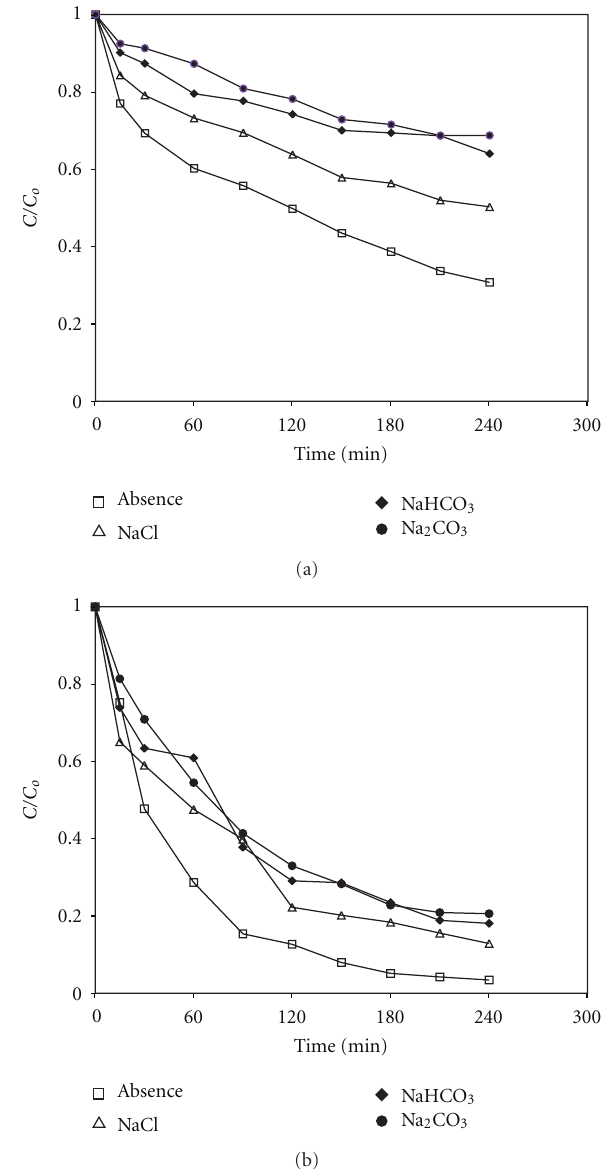
Figure 13: E ff ect of presence of coexisting ions on photocatalytic degradation (a) phenol (b) o- chlorophenol.